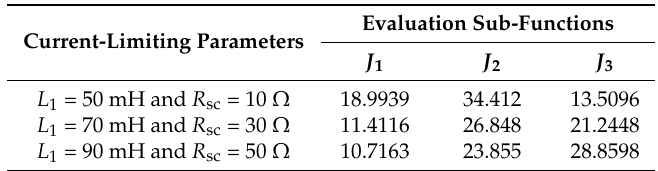
Table 4. Calculation results of the three evaluation sub-functions under different current-limiting parameters (internal fault).